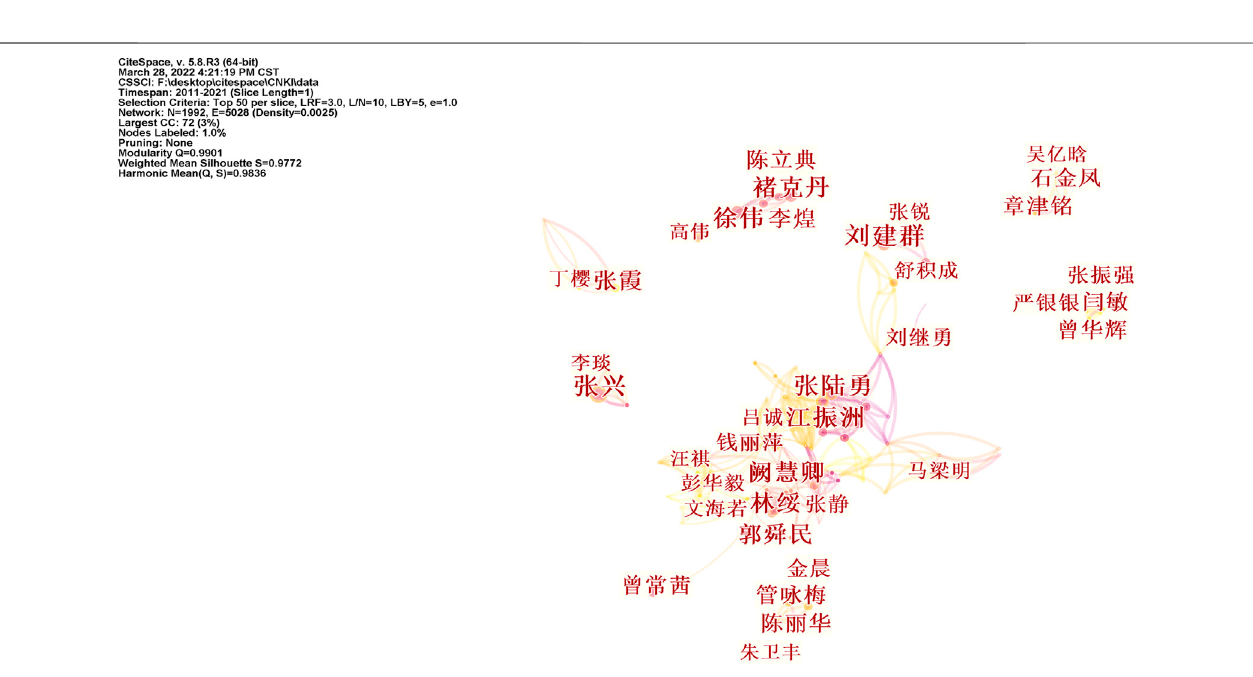
FIGURE 3 | Co-authorship network of triptolide literature keywords from the